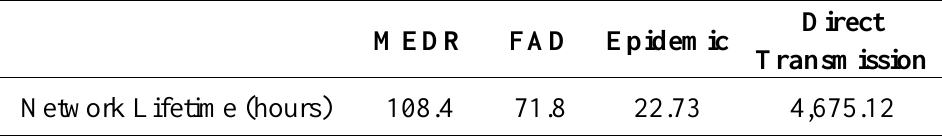
Table 2. Network life with default parameters.